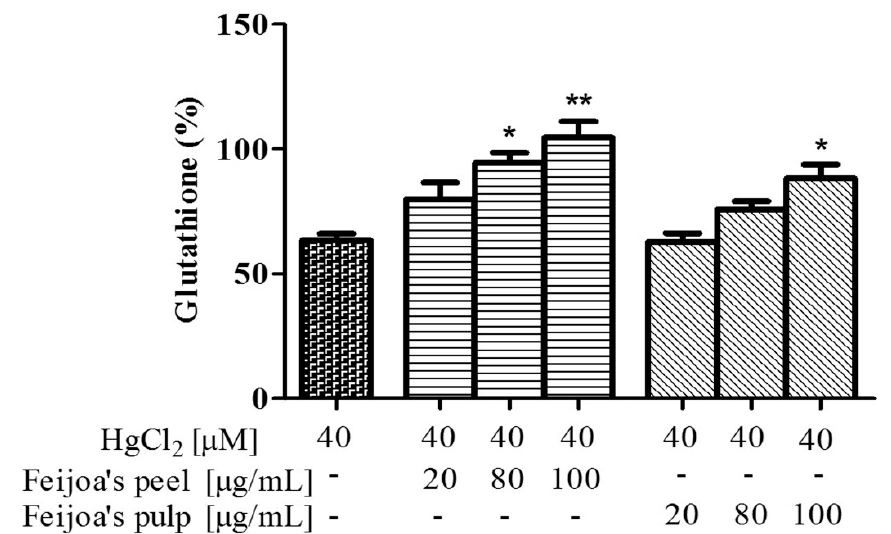
Figure 5. Feijoa peel and pulp extracts protect against Hg-induced glutathione (GSH) decrease in RBC. Cells were treated with 40 µM HgCl 2 for 4 h in the presence of increasing concentrations of Feijoa peel or pulp. Data are the means ± SEM ( n = 9). Statistical significance was calculated with one-way ANOVA followed by Tukey’s test. * ( p < 0.05) and ** ( p < 0.01) indicate significant differences from cells lacking Feijoa extract treatment.